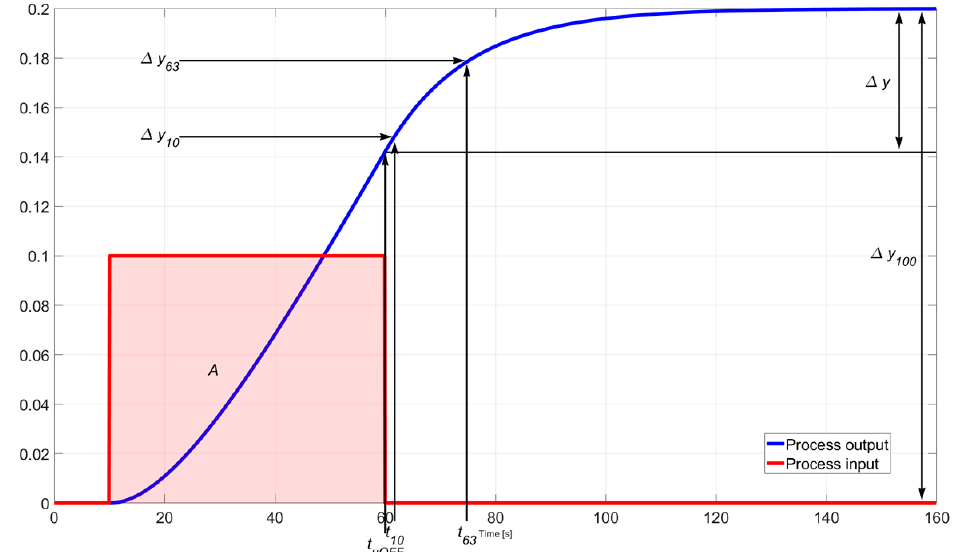
Figure 5. Process identification from wide pulse response for systems with transport delay (wide pulse process excitation—red line, process output—blue line).